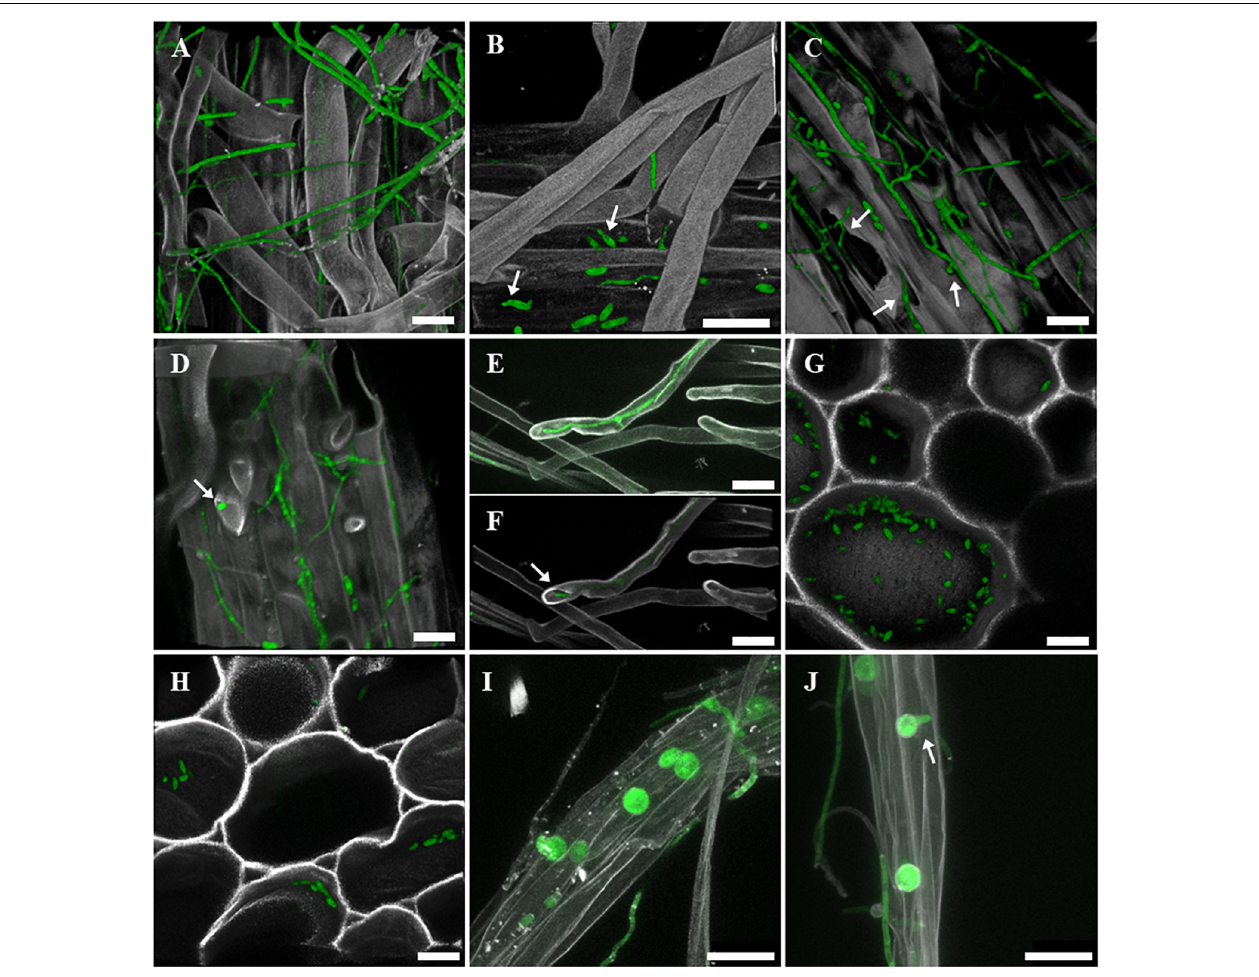
FIGURE 3 | Confocal laser scanning microscopy (CLSM) micrographs showing the colonization pattern of oilseed roots and stem by the strain FO12-sGFP. Green, fungus; gray, host tissues stained with white calcofluor. (A) Extensive root hairs colonization by FO12-sGFP, 10 days after inoculation (DAI). (B) Germinating microconidia (indicated by arrows) attached to the main root tissue at 6 DAI. (C) Extensive main root colonization and root infection by FO12-sGFP toward micro-injuries and by appressorium 8 DAI (arrows indicate micro-injuries and appressorium for FO12-sGFP penetration). (D,E,F) Endophytic behavior of FO12-sGFP growing inside root hairs at 6 DAI (arrows indicate the detail of a hypha inside the root hair). (G,H) Conidial spread of FO12-sGFP toward the stem, 17 DAI. (I,J) Embedded chlamydospores in root hairs bundles at 14 DAI (arrow indicates a germinating chlamydospore). Scale bars: 25 µ